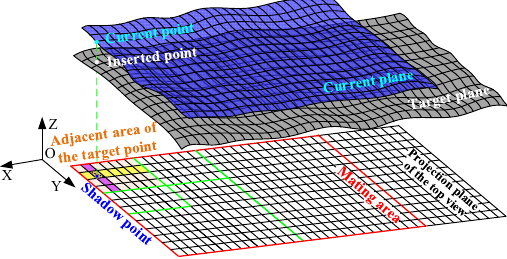
Figure 16. Principle of computing the distances between the corresponding points by determining the adjacent area.